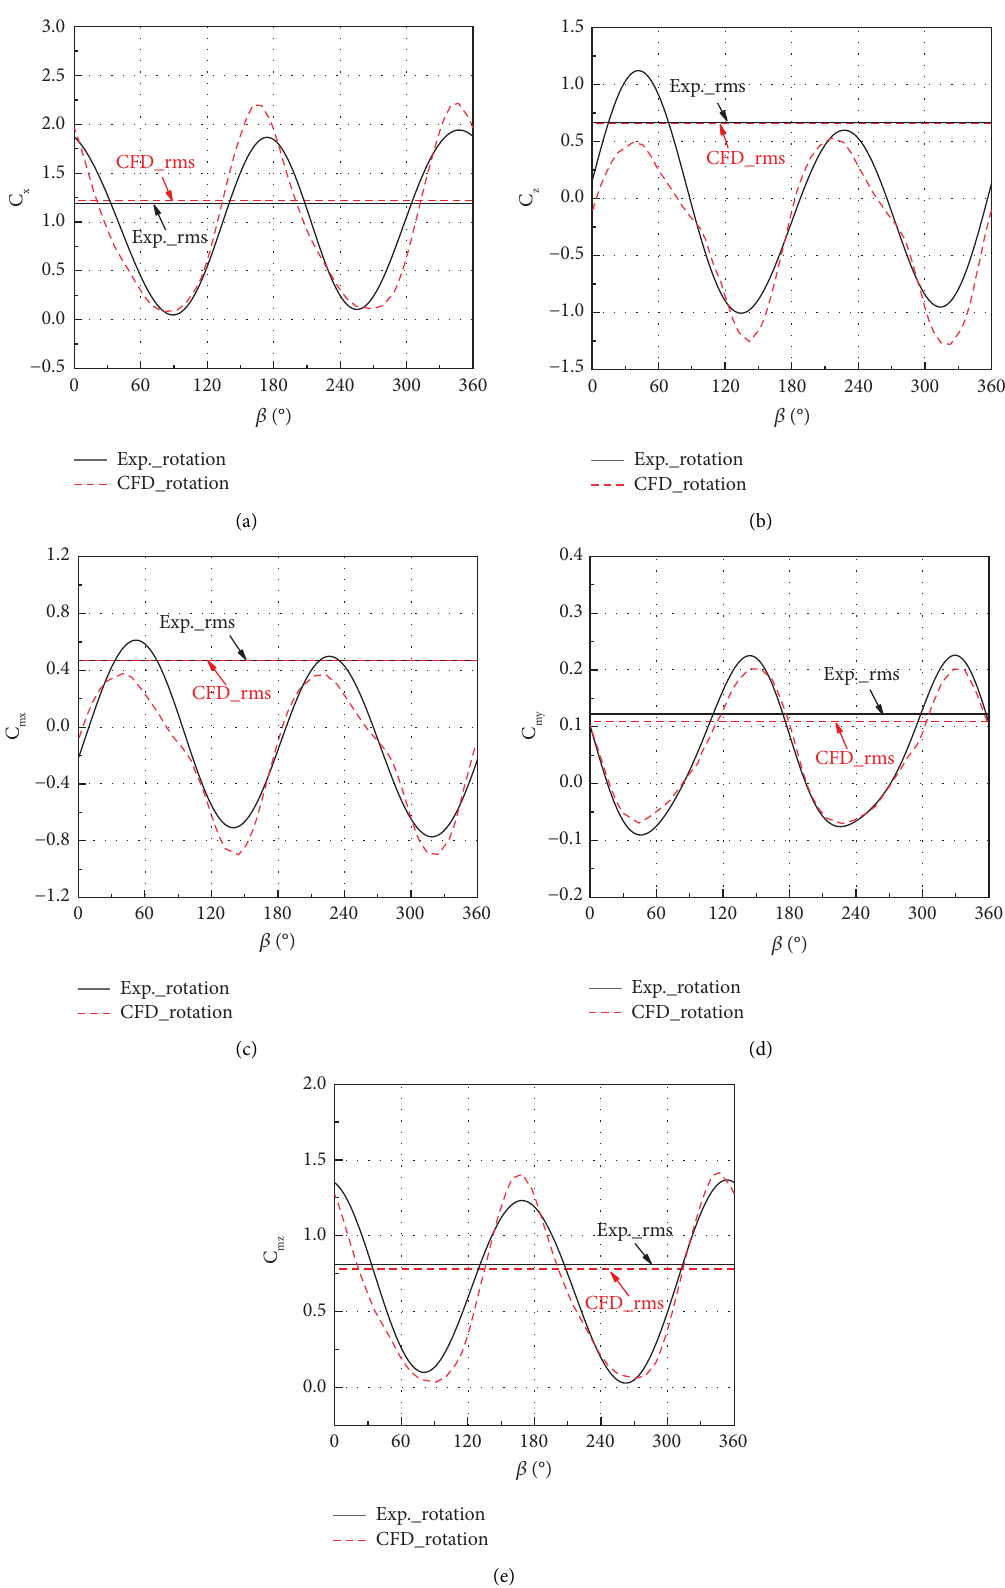
Figure 7: Wind tunnel test results and numerical simulation results of aerodynamic coefficient with respect to azimuth angle when the antenna rotates in azimuth (solid plate, K � 0.11). (a) C x − β , (b) C z − β , (c) C mx − β , (d) C my − β , and (e) C mz − β